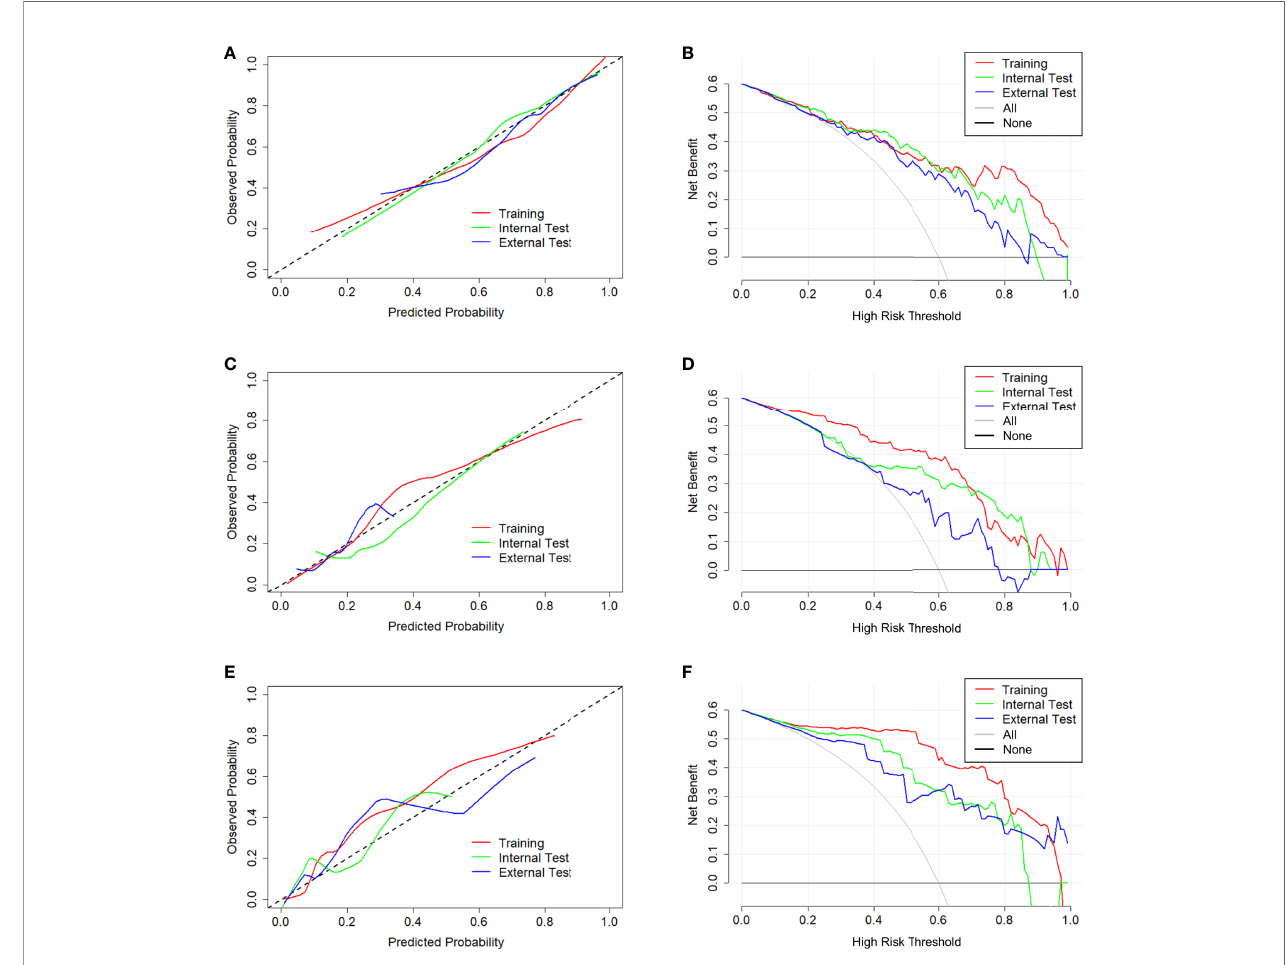
FIGURE 6 | Calibration curve and decision curve of CCRMs in tasks 1 – 3. Calibration curve (A) and decision curve (B) of CCRMs for the prediction of HR-positive and HR-negative in task 1. Calibration curve (C) and decision curve (D) of CCRMs for the prediction of HER2-enriched and non-HER2-enriched in task 2. Calibration curve (E) and decision curve (F) of CCRMs for the prediction of TNBC and non-TNBC in task 3. In the calibration curve, the gray dotted line represents the ideal line of the model. In decision curves, the gray solid line represents the net bene fi t for all patients after pathological diagnosis (All), and the black solid line represents the net bene fi t for none patients after pathological diagnosis (None).